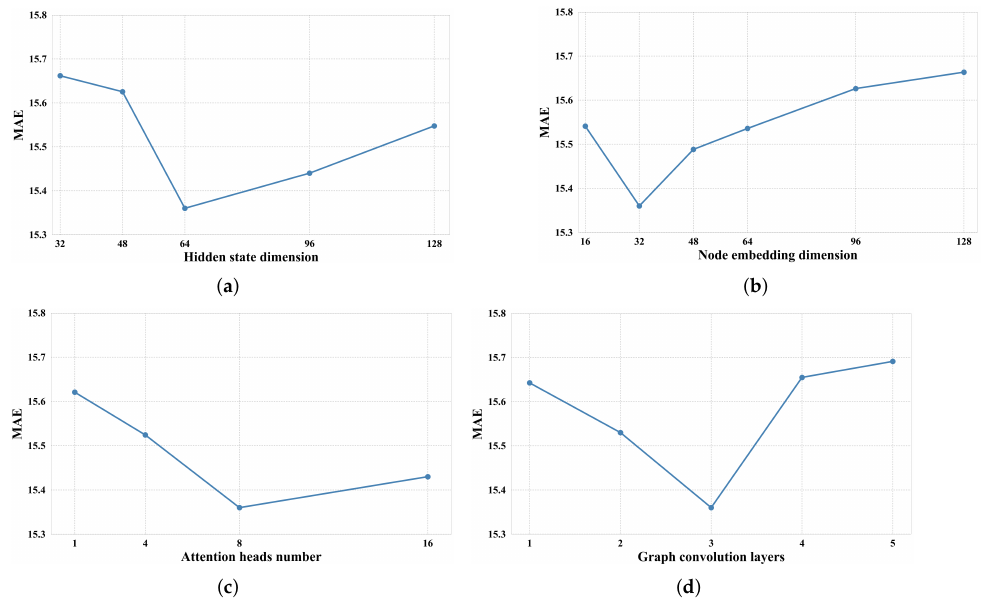
Figure 6. Parameter study on PEMSD8. ( a ) Effects of hidden state dimension, ( b ) effects of node embedding dimension, ( c ) effects of attention head number, ( d ) effects of graph convolution layers. Table 3. Comparison of different static graph learning methods.